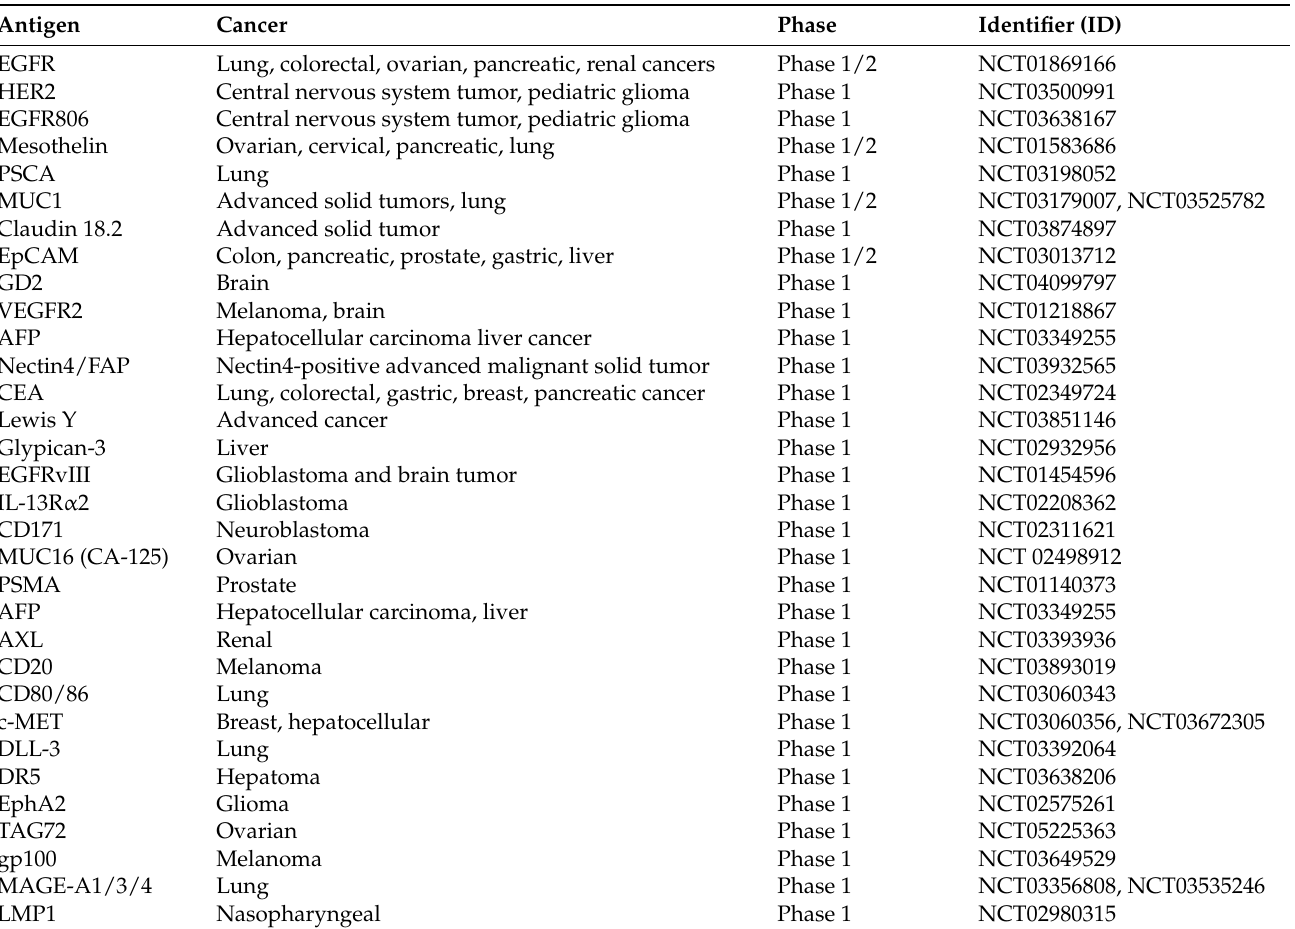
Table 2. Most targeted antigens in clinical trials of CAR T-cell therapy in solid